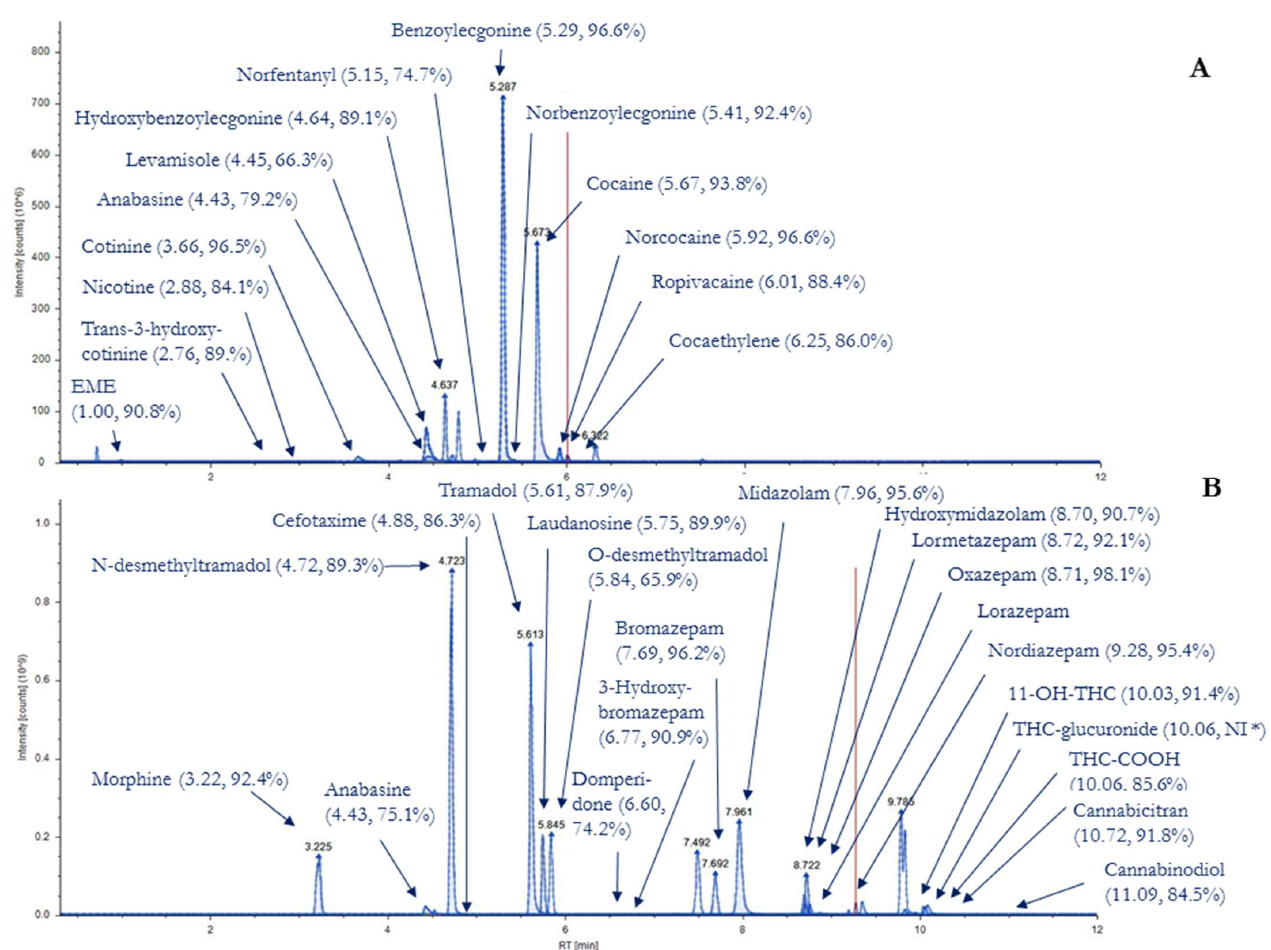
Figure 2. Presentation of the extracted ion chromatograms (EIC) for the substances identified in sample nº 4 ( A ) and sample nº 14 ( B ) (retention time, similarity score with the MzCloud™ spectral library). * THC-glucuronide was not identified with MzCloud™ and NIST library (NI), but solely with the house made library.